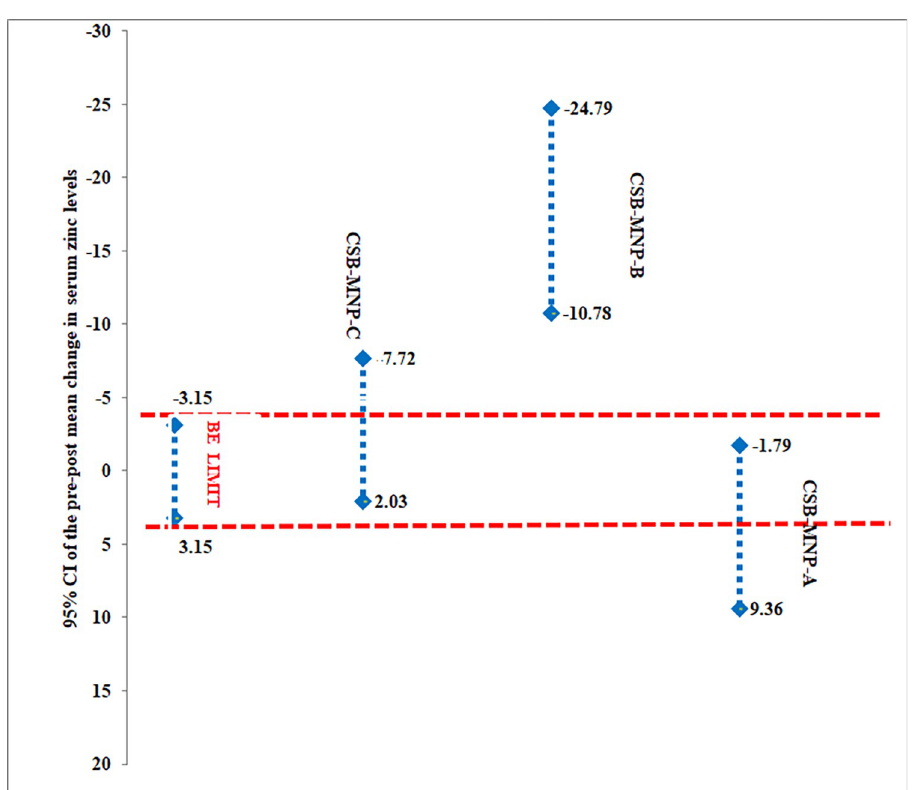
Fig 3. Bioequivalence of MNP formulations compared to